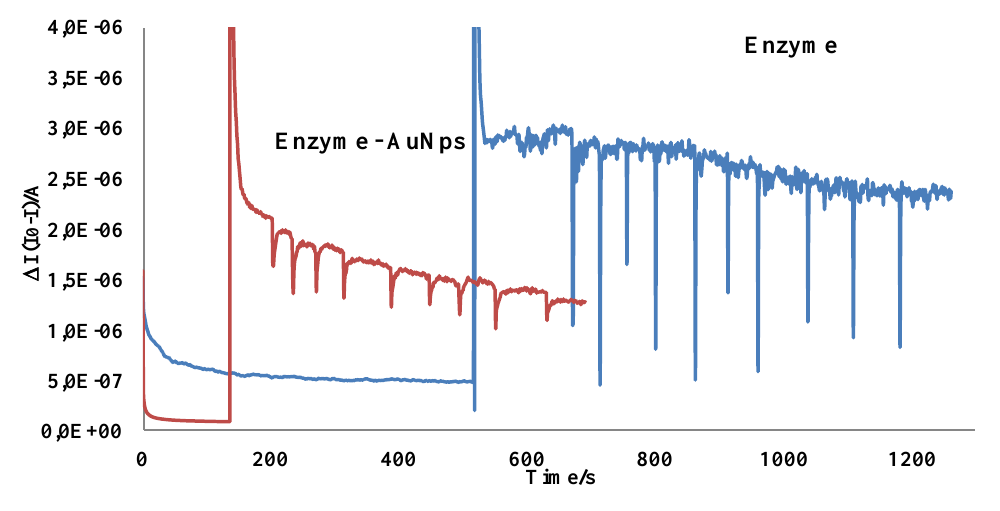
Figure 7. Calibration curves realized with enzyme acetilcholinesterase and AuNps and without